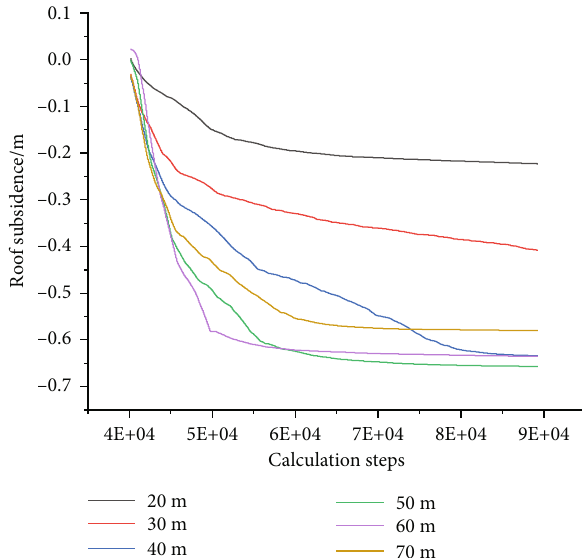
Figure 19: Roof subsidence at di ff erent calculation steps.